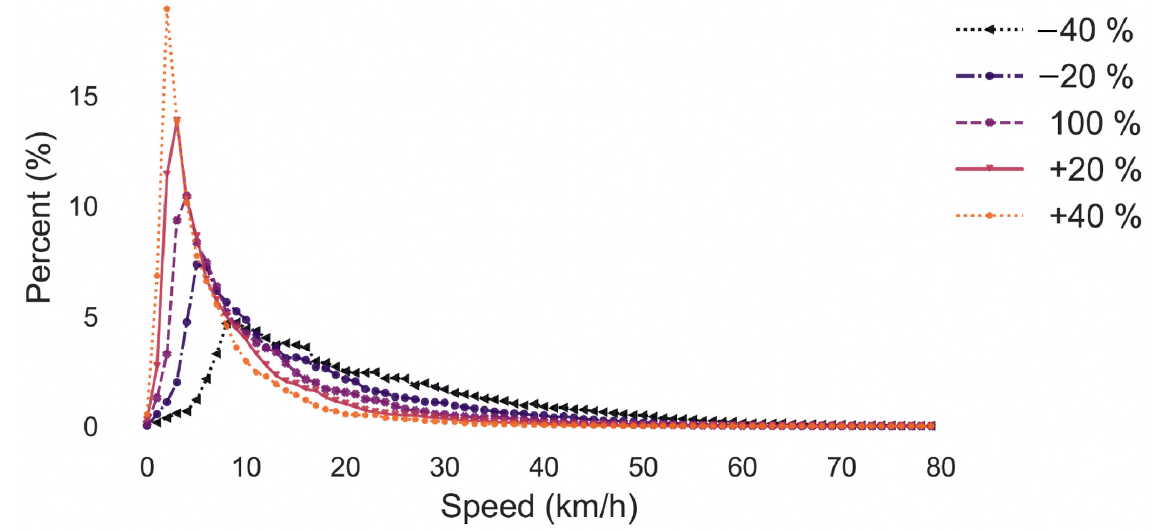
Figure 4. Speed for various demand levels (scenario 1). Percent refers to the share of trips which have a specific average speed.